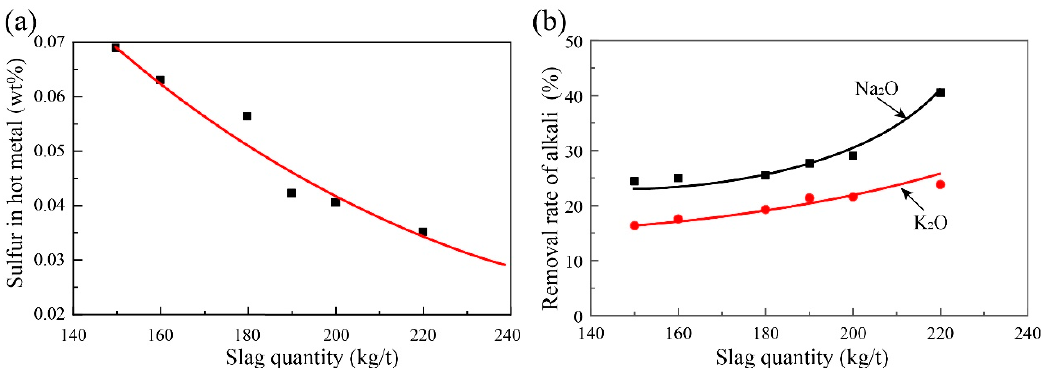
Figure 2. The effect of the slag quantity on the desulfurization and the removal of alkali behavior. ( a ) Desulfurization; ( b ) the removal of alkali.